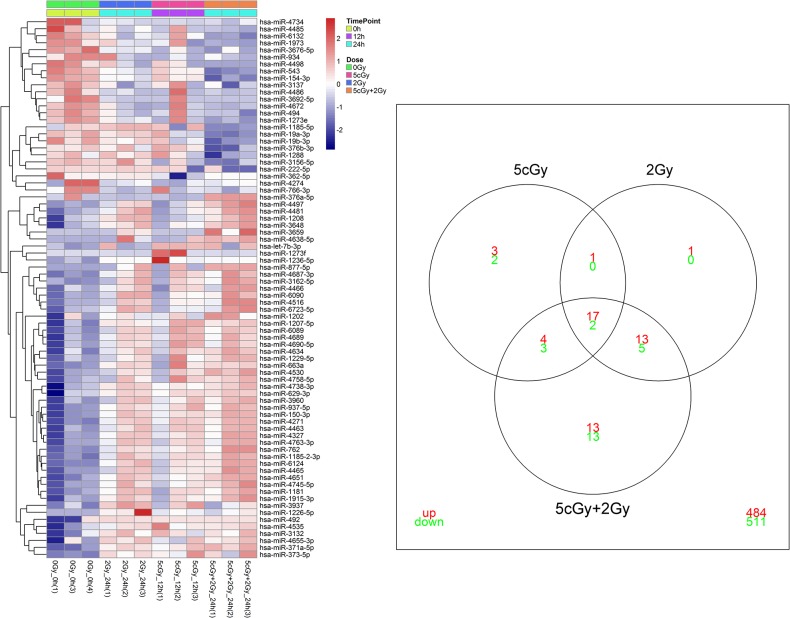
The heatmap of expressed miRNAs and Venn diagram of overlap for the three irradiation groups.The left panel shows the significantly expressed miRNAs using Bayes’ estimation in the limma package. The right panel shows the Venn plot of DEG numbers of the three groups, with green and red colors code for the numbers of down-regulated and up-regulated genes, respectively.